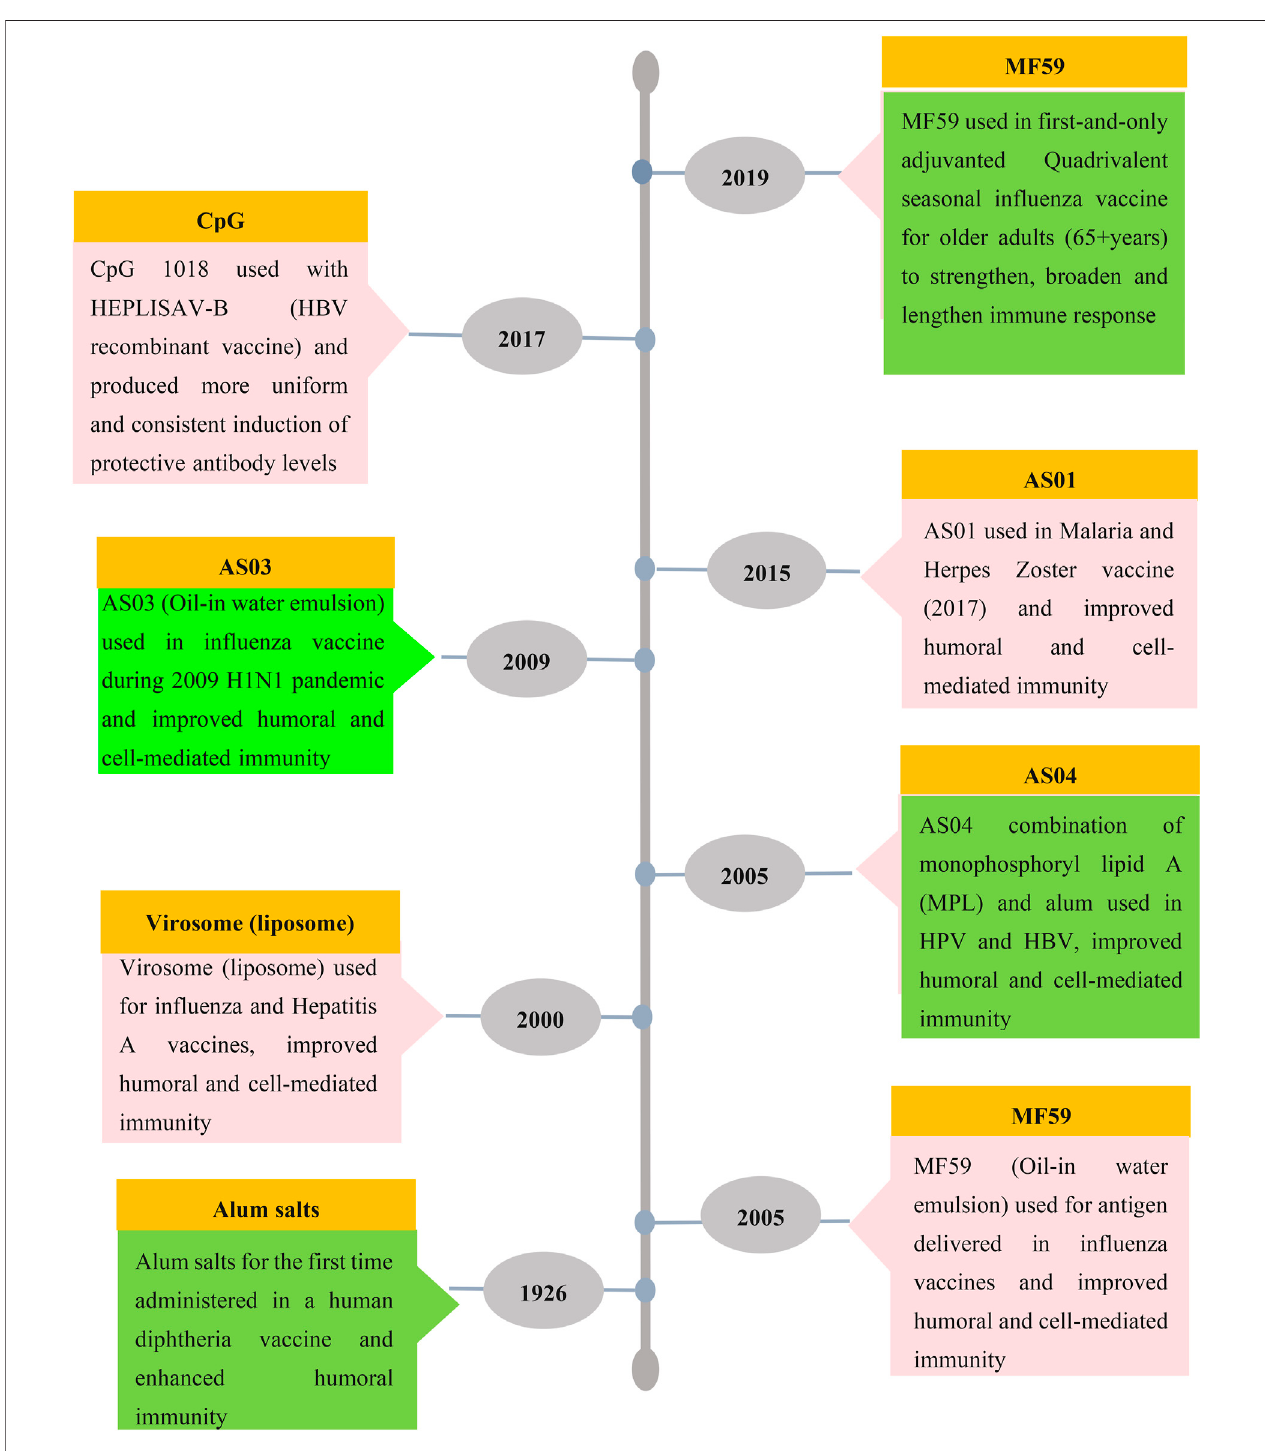
FIGURE 2 | Timeline of licensed vaccine adjuvants. Aluminium salt was the fi rst and most used adjuvant with other limited adjuvants such as MF59, virosome, AS01, AS03, AS04 and CpG ODN which are used in FDA-approved vaccines for humans.